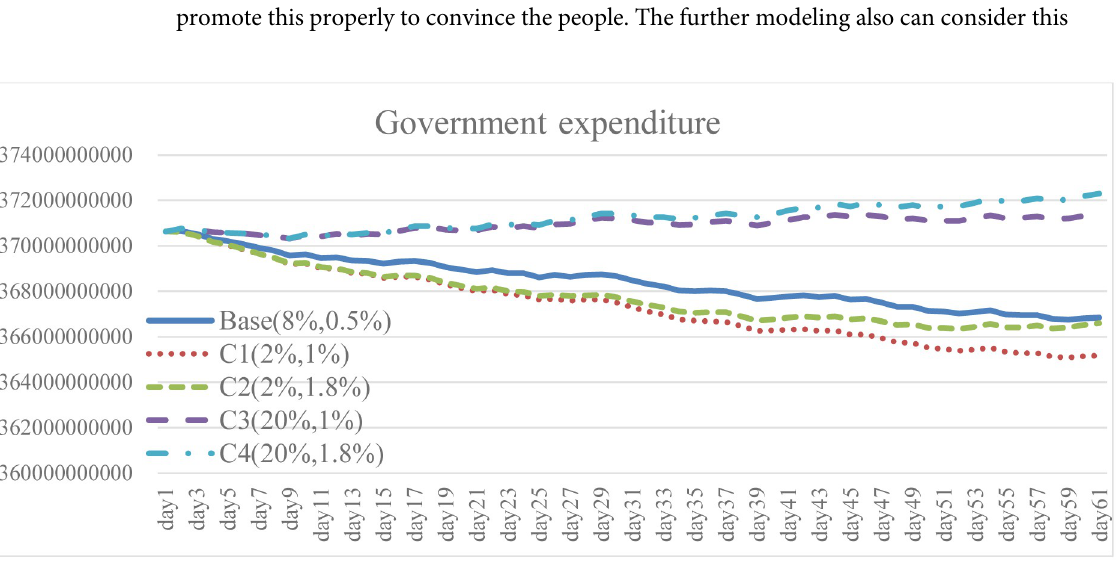
Fig 21. Government expenditure under different isolation percentage and vaccine